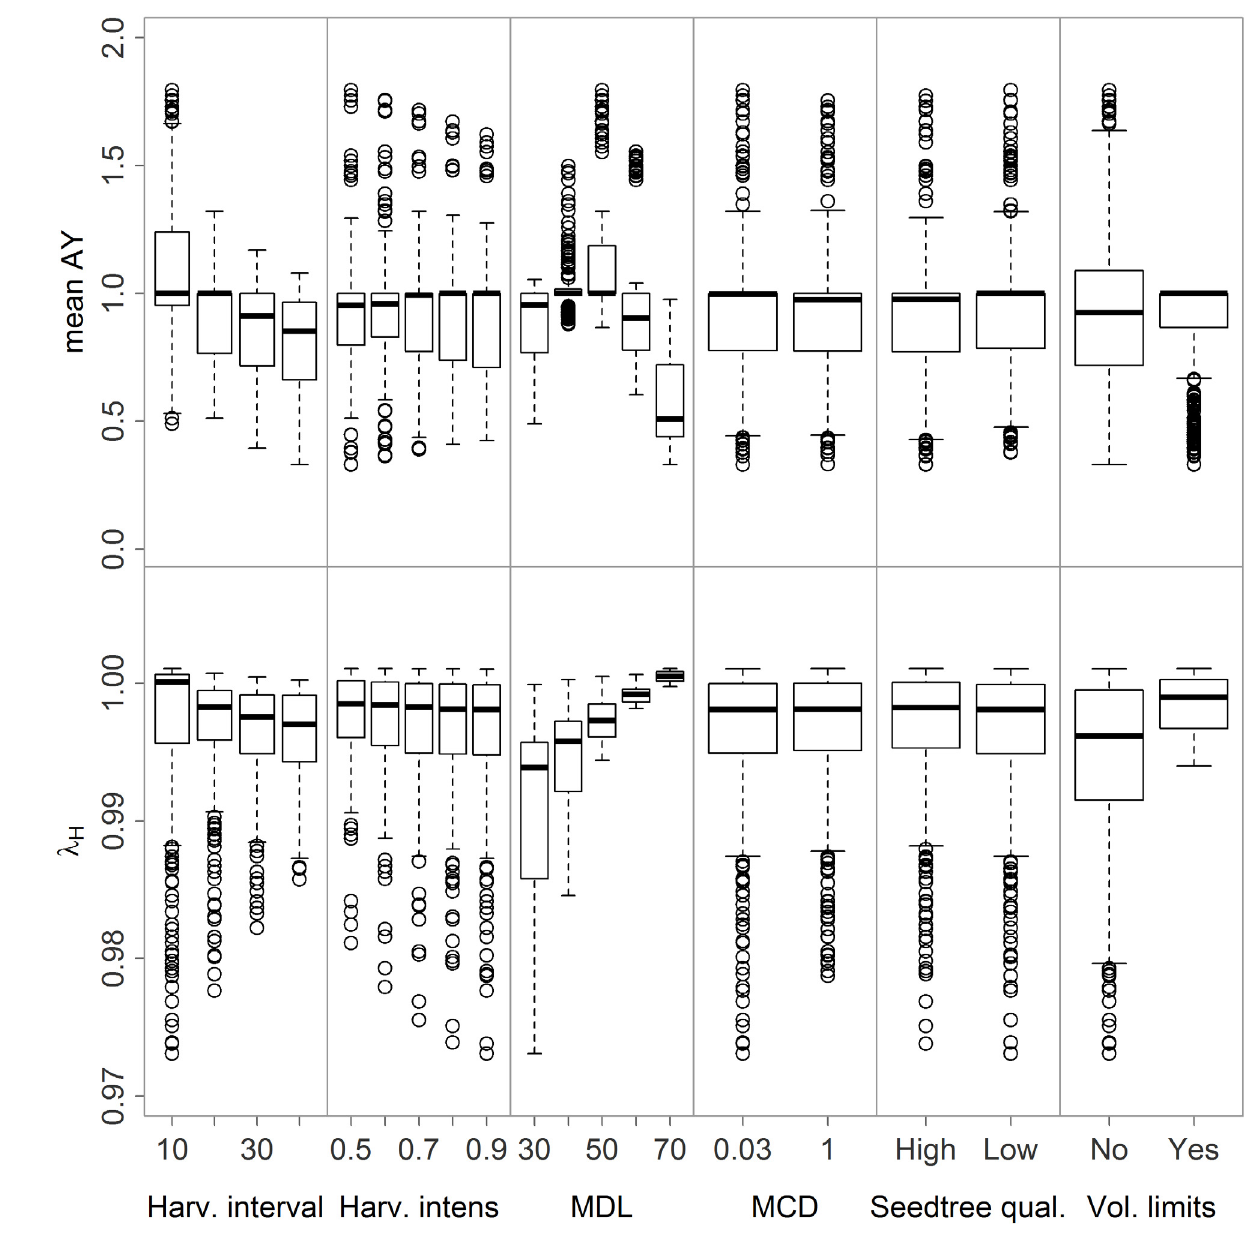
Fig 3. Simulation-based spread of mean AY and λ H in response to varying management